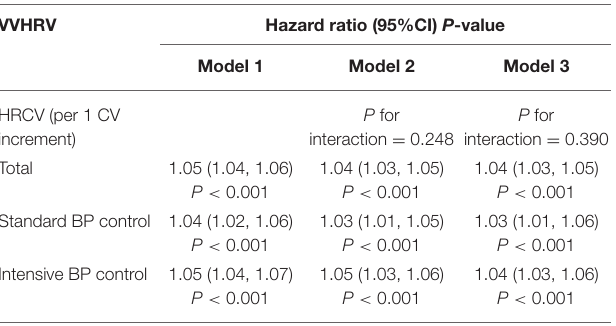
TABLE 3 | Continuous Association between visit-to-visit heart rate variability and composite cardiovascular outcomes in different models. VVHRV